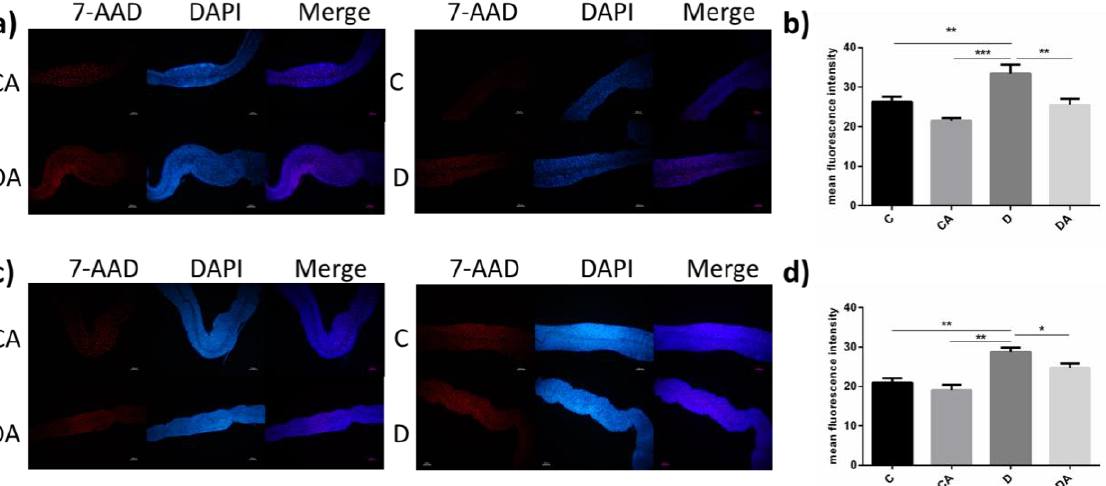
Figure 4. Effect of BANCs on the mortality of intestinal epithelial cells in DSS-treated female D. melanogaster . C, CA, D, and DA represent the blank control group, BANC control group, inflamed group, and BANCs + inflamed group, respectively. The midguts of normal ( a , b ) and axenic ( c , d ) female D. melanogaster in each group were stained for 7-AAD (red) and DAPI (blue). Scale bar: 50 µ m. Data from triplicate repetitions are expressed as the means ± SEMs. Statistical significance: * p < 0.05, ** p < 0.01, *** p < 0.001.